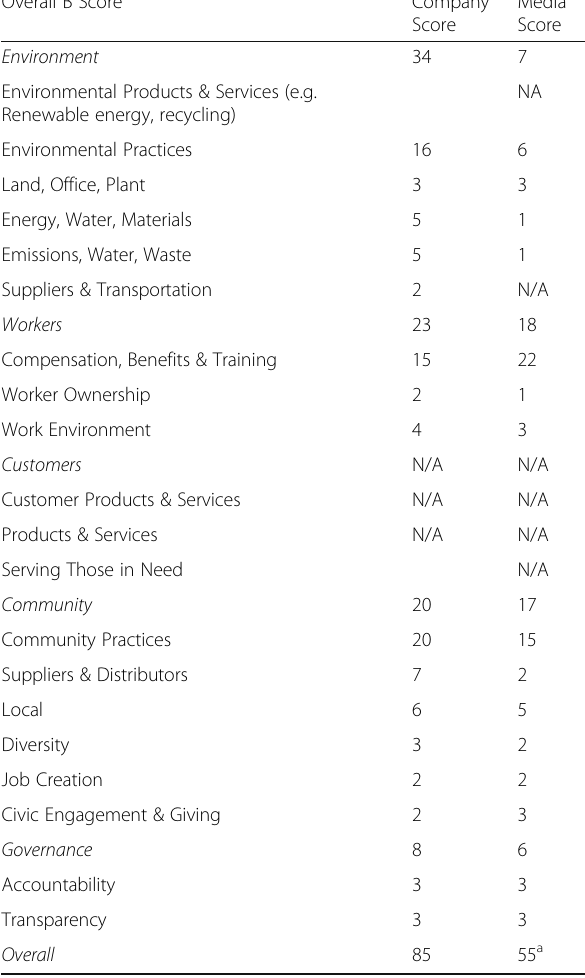
Table 4 Paradisi B Impact report (2016) Overall B